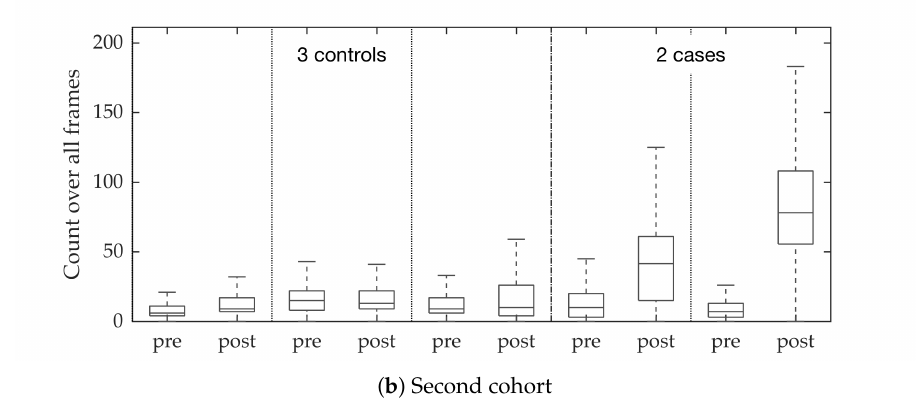
Figure 13. Estimated bacterial load in each image frame of 22 FCFM videos for 6 controls and 5 cases, pre- and post-substance.